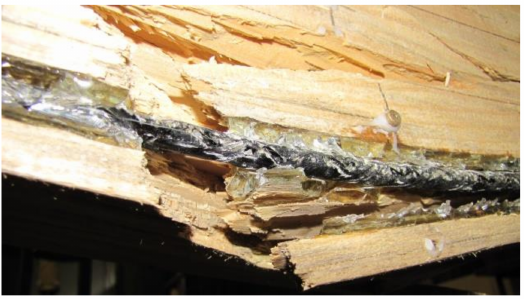
Figure 9. Sample image of the failure of a wooden beam reinforced with natural fibre (W BFRP -A2) (photo by: